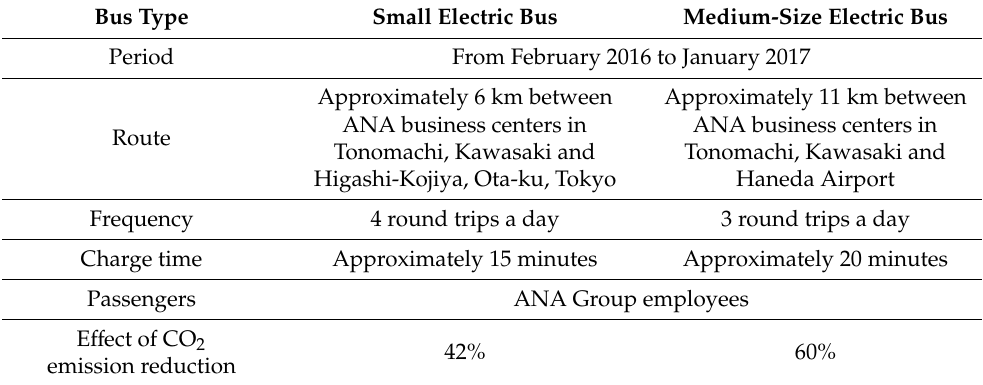
Table 2. Overview of result of field